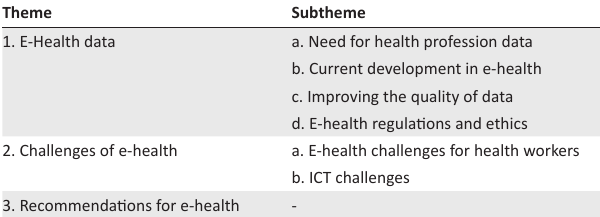
TABLE 4: Identification of themes and